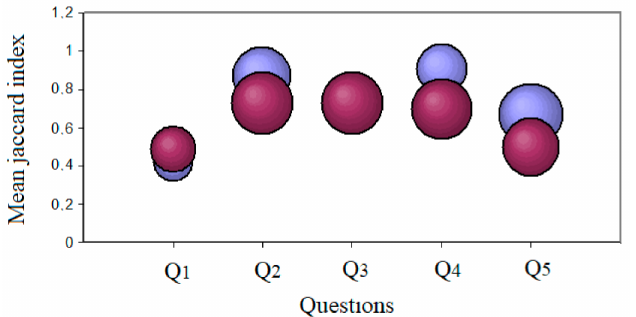
Figure 6. Values of the mean Jaccard index (with their standard deviations) per question, for the comparisons between the 20–35 and 36–51 age groups (purple balls) and 20–35 and >52 age groups (blue balls): the 20–35 and >52 age groups had higher means of agreement than the 20–35 and 36–51 age groups for all questions except for question 1.